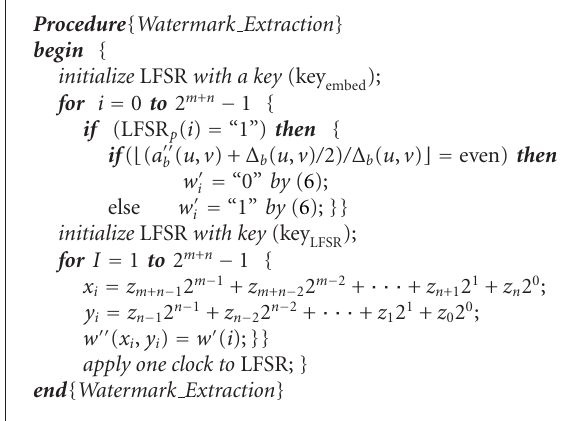
Algorithm 3: Watermark extraction